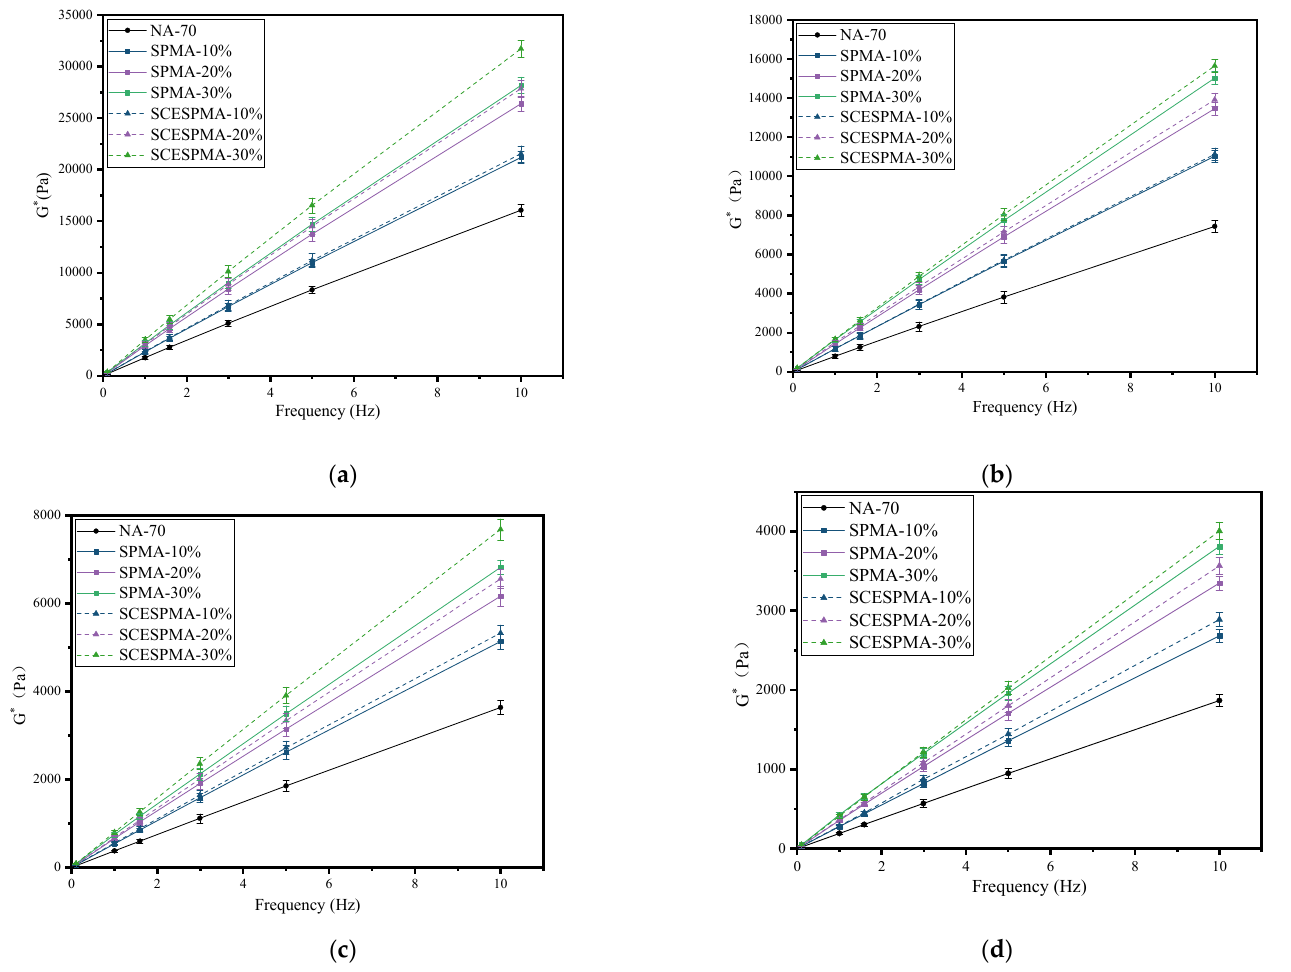
Figure 9. Relationship among G * and frequency of SPMA and SCESPMA at different temperatures.